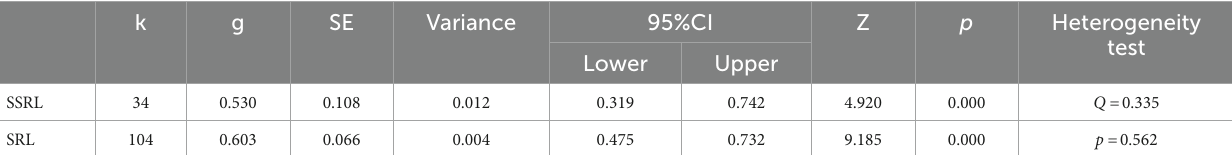
TABLE 3 Effect sizes by type of regulated learning.